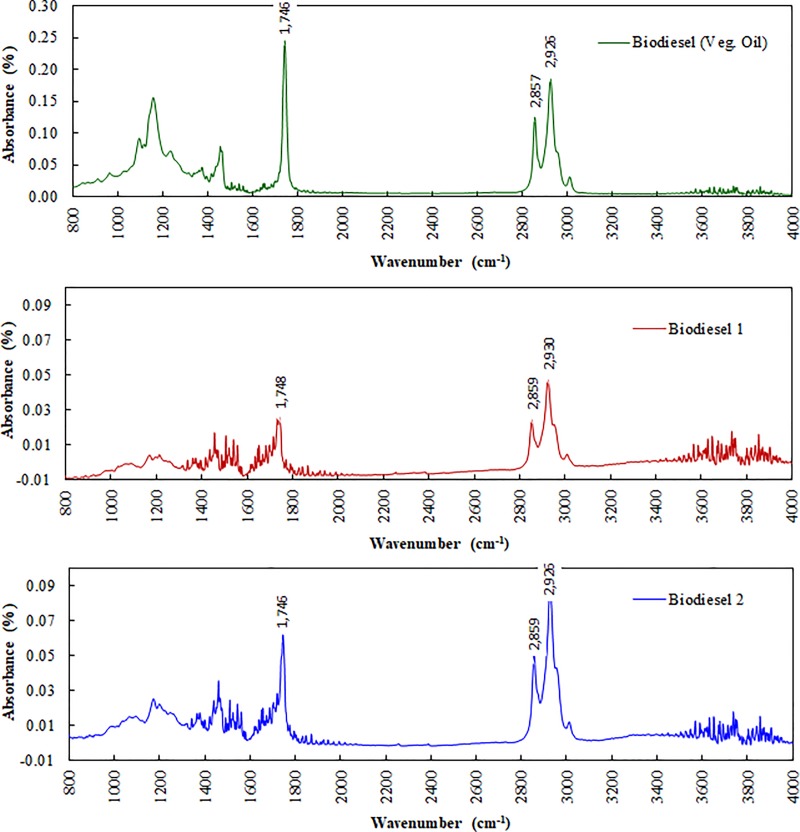
FTIR absorbance spectrum on biofuels samples after transesterification.